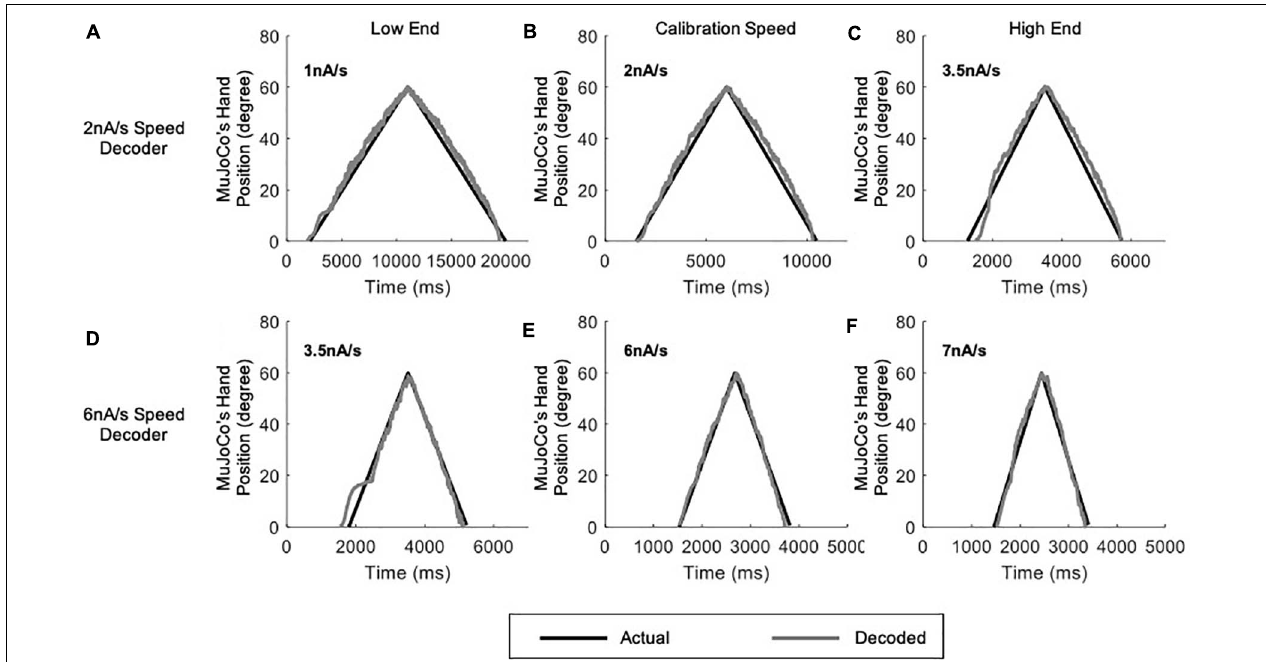
FIGURE 5 | Testing of the adaptive 2-speed decoder across a range of activation speeds. All panels include comparison of MuJoCo’s hand position when driven by the actual (black) vs. decoded (gray) inputs. Decoder calibrated to 2 nA/s input tested on a 1 nA/s (A) , 2 nA/s (B) , and 3.5 nA/s (C) inputs. Decoder calibrated to 6